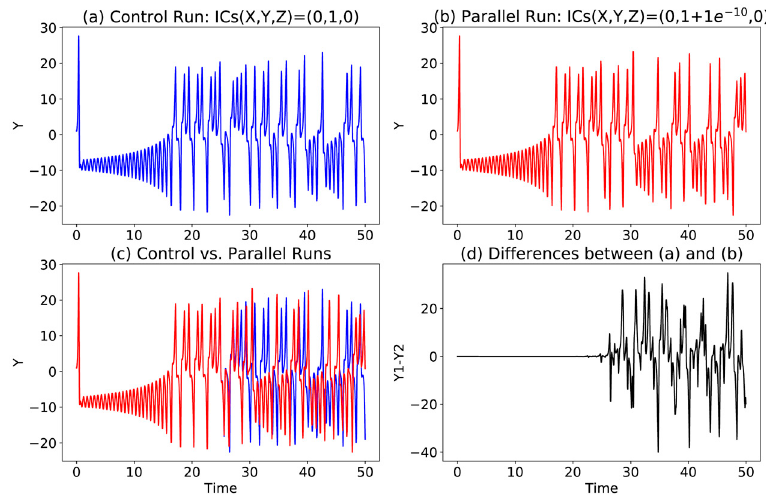
Figure 2. An illustration of the bounded divergence of two nearby trajectories within the 3DLM with r = 28 and σ = 10. Panels ( a ) and ( b ) display solutions from the control and parallel runs, respectively, the latter of which adds a small perturbation (1 × e − 10 ) into the initial value of Y. Panel ( c ) reveals the sensitive dependence of solutions on the initial conditions. Panel ( d ) displays bounded differences in solutions for the control and parallel runs.